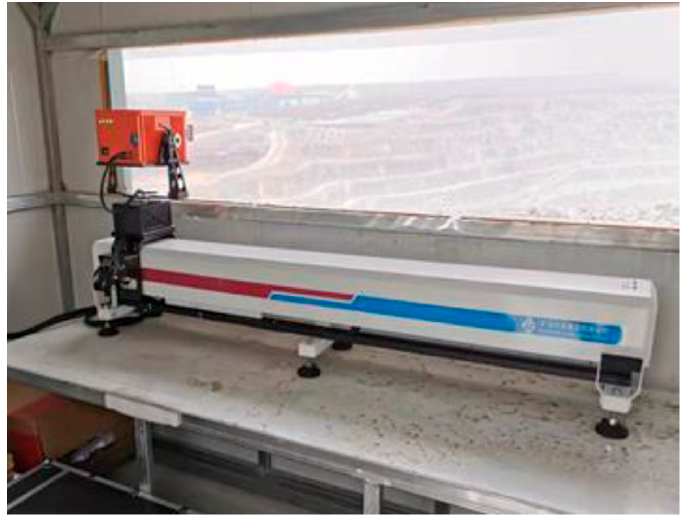
Figure 9. The Frequency Modulated Continuous Wave Ground-Based Synthetic Aperture Radar (FMCW-GBSAR) System from NCUT (Reprinted from Ref. [63]). (FMCW-GBSAR) System from NCUT (Reprinted from Ref.